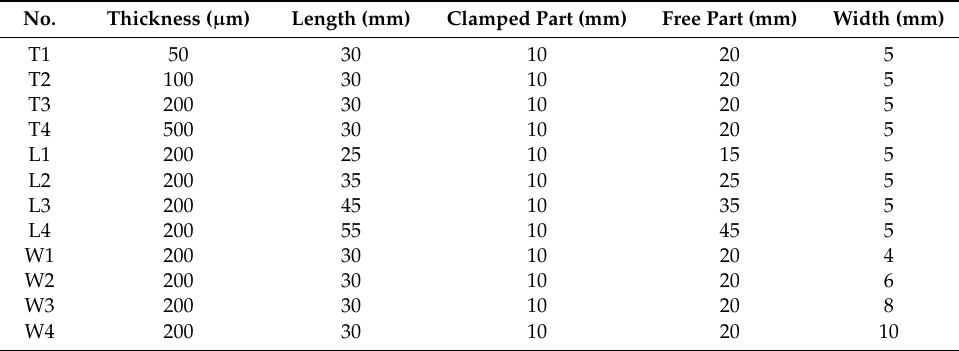
Figure 3. IPMC samples with dimension difference. Table 1. The size parameters of the ionic polymer-metal composite (IPMC).